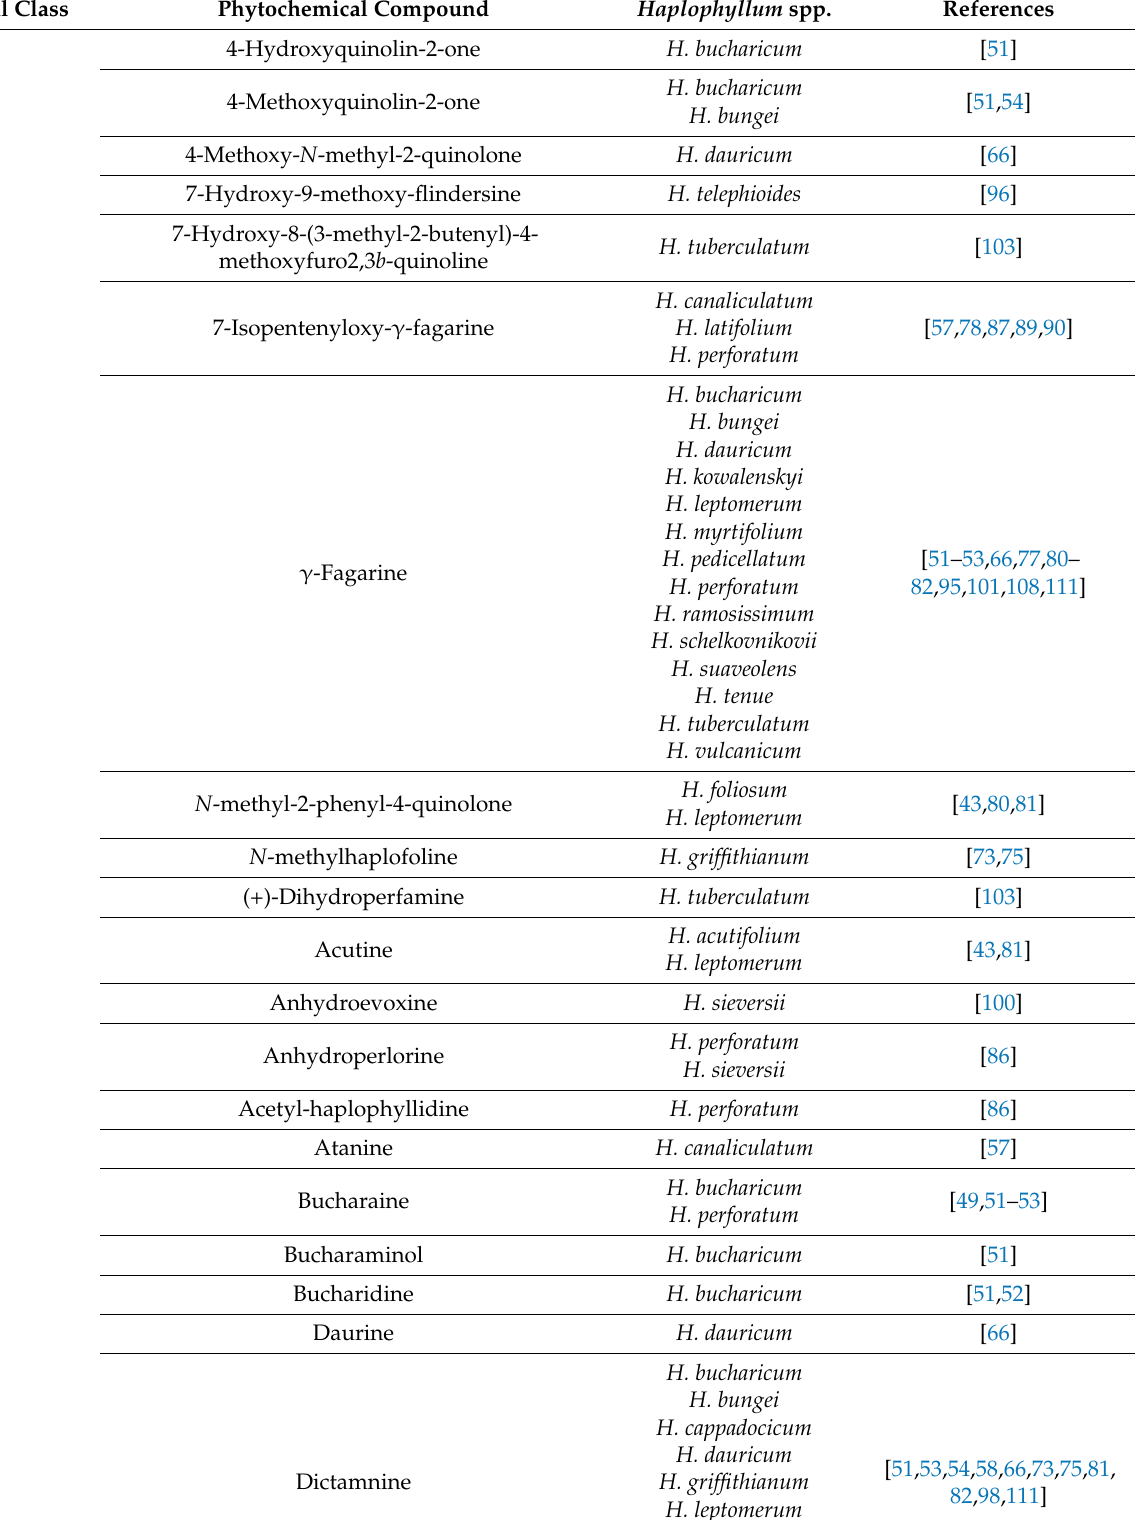
Phytochemical Class